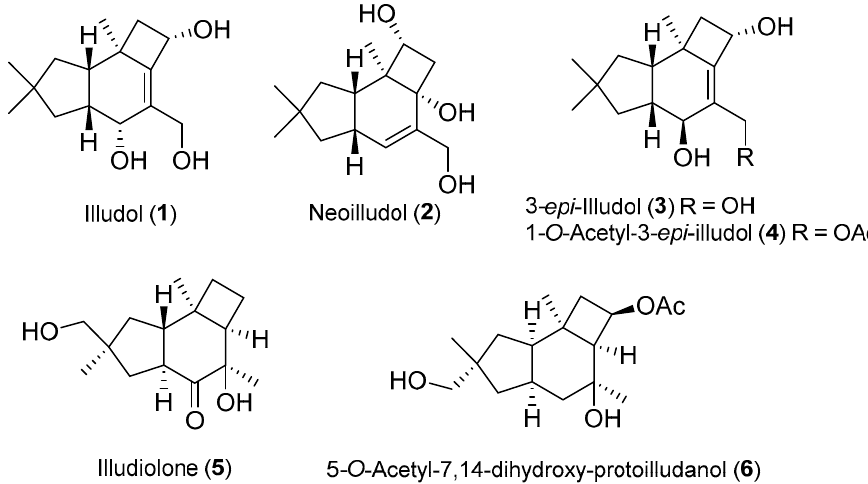
Figure 3. Structures of protoilludanes 1 – 6 isolated from the Clitocybe and Omphalotus genera of